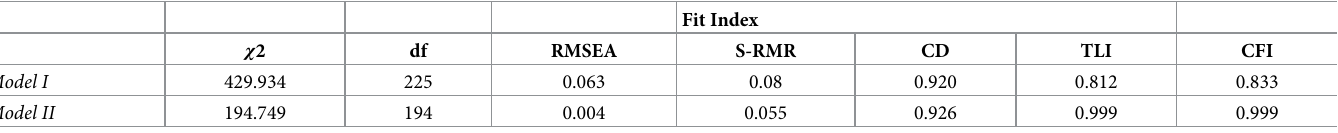
Table 3. Fit Indices of the whole